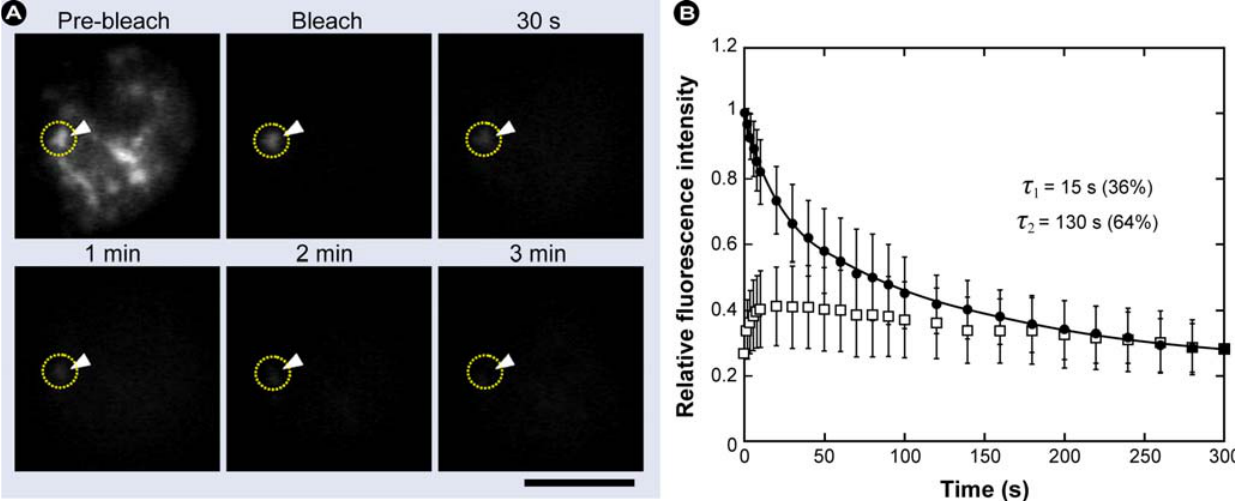
Figure 14. iFRAP experiment showing the dissociation of pre-mRNA from speckles. ( A ) Fluorescence images of a Cos7 cell micro-injected with pre-mRNAs before and after photobleaching of the nucleus except for the speckles region (ROI) shown by the arrowheads and circle. Scale bar, 10 μ m. ( B ) The changes in fluorescence intensity after photobleaching at time 0 at the speckles (closed circles) and in its adjacent photobleached nucleoplasm (open squares) was plotted as a function of time. The curve shows a rapid dissociation, followed by slow-dissociation from speckles and slightly increased fluorescence intensity at the adjacent nucleoplasm for about 10s after the photobleaching and then reaching a value similar to that of the speckles. Reprinted from [127] with permission. © 2008